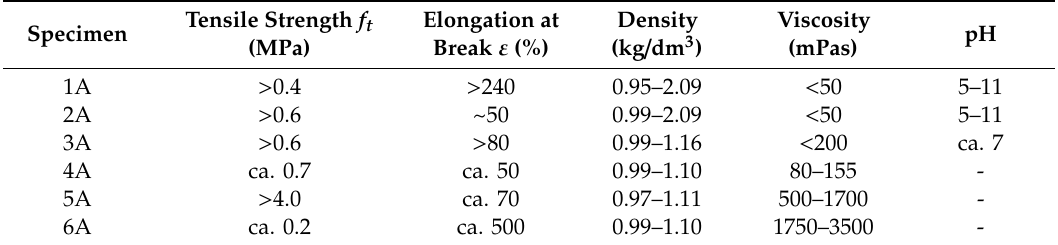
Table 1. Resin specimens—tensile strength f t elongation at break ε , density, viscosity and pH.